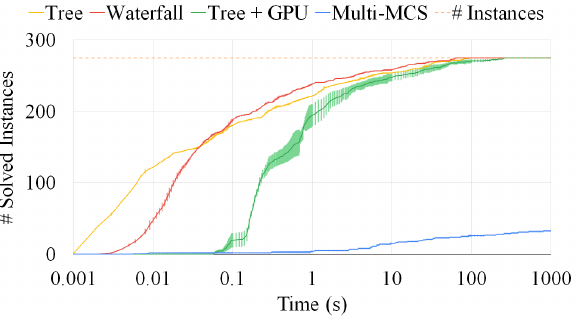
Figure 13. A comparison among the Multi-MCS, the waterfall, and the tree approaches. The plot reports the number of sets composed of six graphs solved as a function of the elapsed time. The fluctuations on the y-axis are due to the representation of the standard deviation over ten runs. The time limit is fixed at 1000